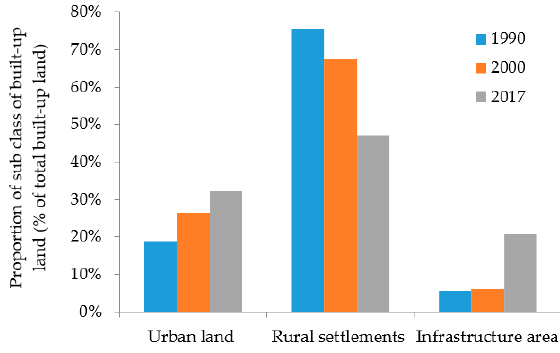
Figure 11. Proportion of sub-class of built-up land change in 1990, 2000, and 2017. Appl. Sci. 2018 , 8 , x FOR PEER REVIEW